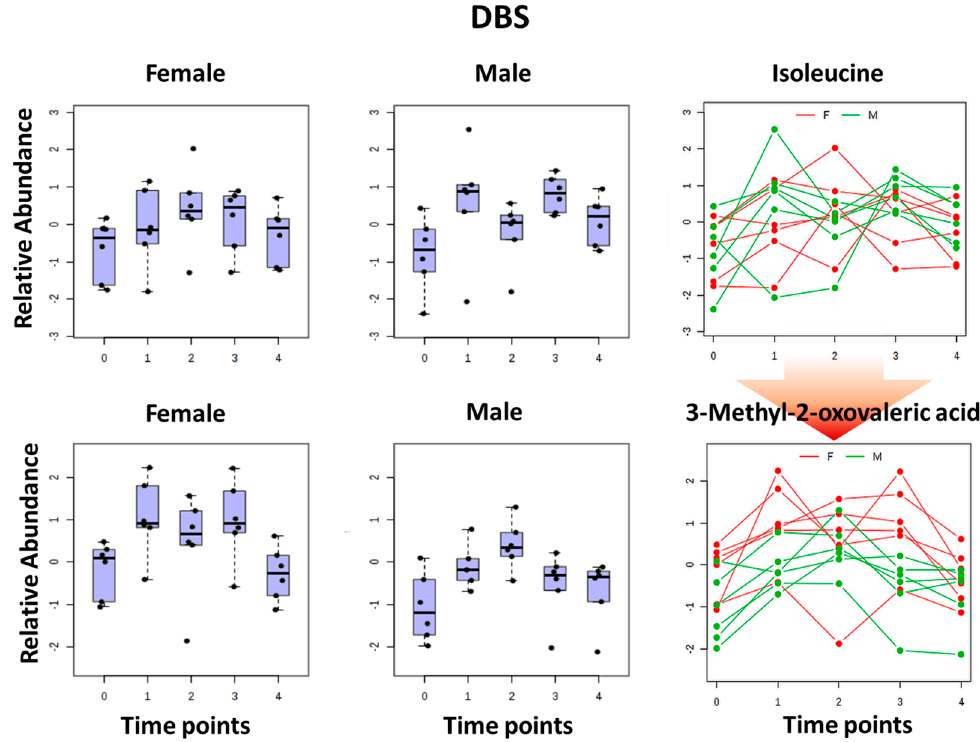
Figure 7. Two way ANOVA analysis results. Upper panel depicts isoleucine intra-day variations in the blood metabolome. Lower panel shows 3-methyl-2-oxovaleric acid intra-day variations in the blood metabolome. 3-methyl-2-oxovaleric acid is a downstream metabolite of isoleucine in humans (red arrow). Y axis shows normalized relative abundance. X axis illustrates intra-day time points corresponding to fasting, 7 AM, 10 AM, 1 PM, 4 PM, and 7 PM (0–4, from left to right).